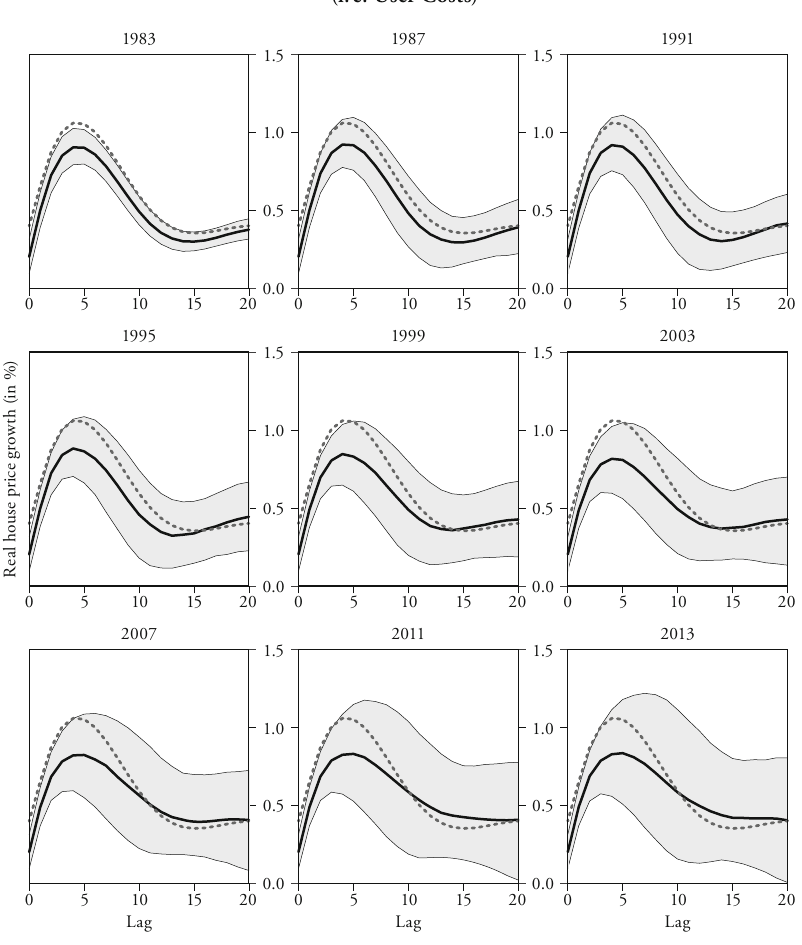
Figure 8: Response of House Prices to a Shock on the Mortgage Rate Change (i. e. User